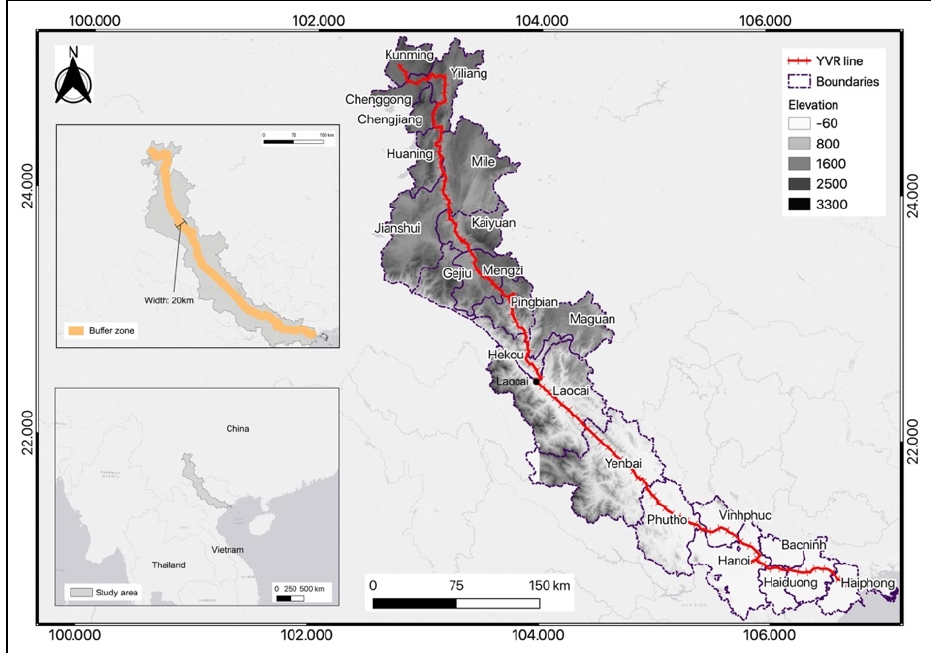
Figure 1. Study area. The created buffer zone inside the study area and the global location of the study area are also included in this figure.